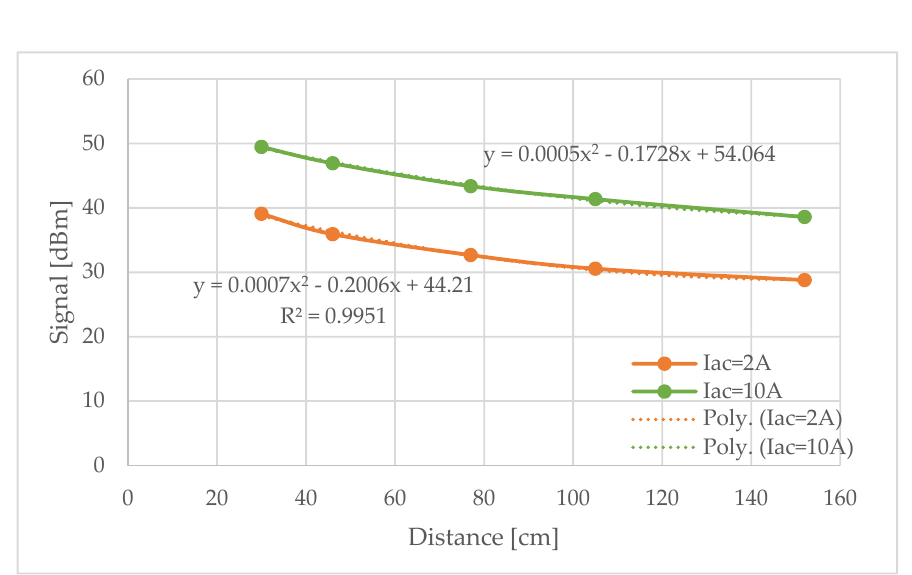
Figure 11. Experimental amplitude of the torsional wave signal as a function of distance (in dBm).